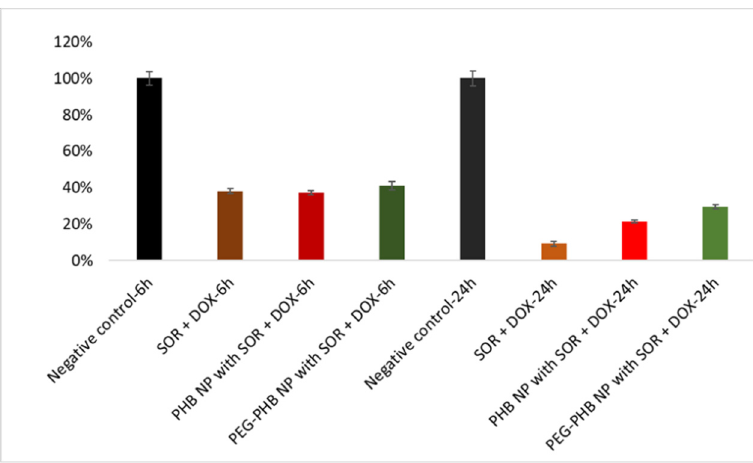
Figure 11. Viability of HCT-116 cells treated with sorafenib—(SOR)- and doxorubicin—(DOX)-loaded PHB and PEGylated-PHB nanoparticles and with the solution of drugs and that of untreated cells (negative control).